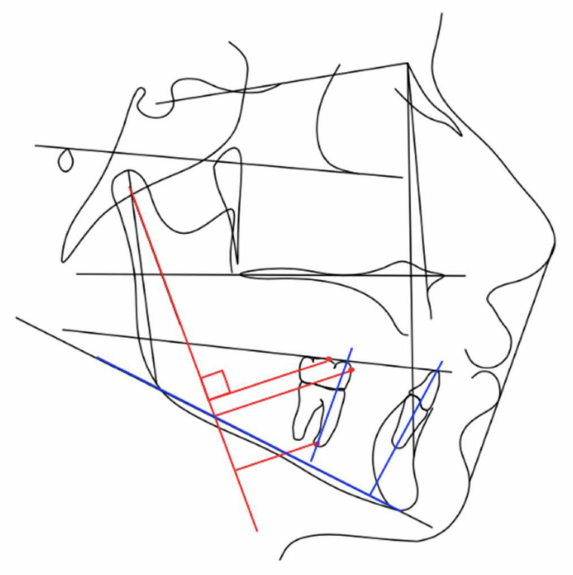
Figure 1. Cephalometric analysis